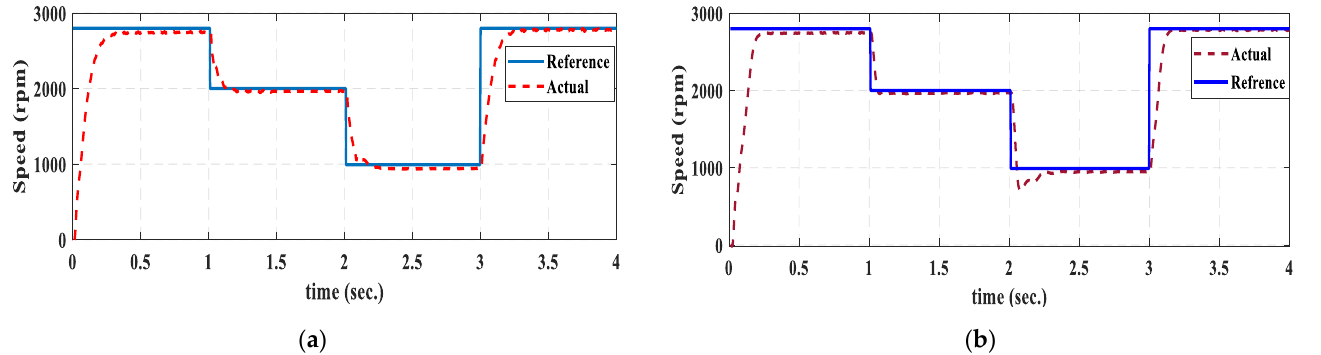
Figure 6. Speed–time characteristics: ( a ) with 3-phase inverter and transformer, ( b ) with 6-phase inverter.